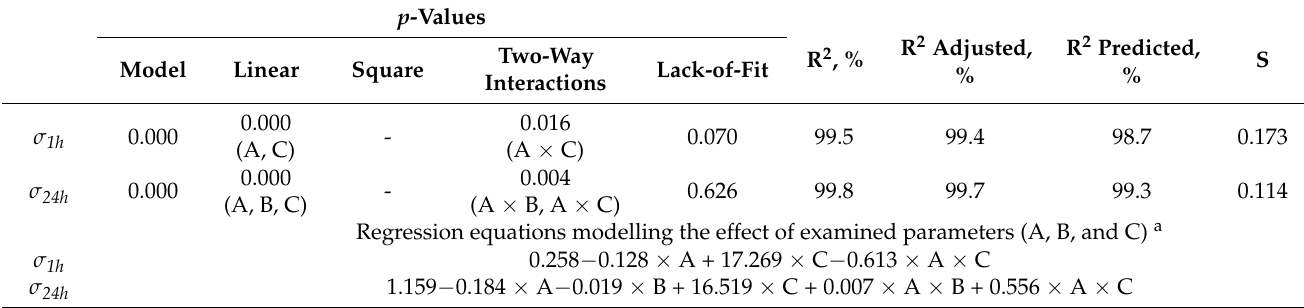
Means of σ 1h and σ 24h , assessed for the Box-Behnken response surface design were fitted next with full quadratic functions, including linear (A, B, C), square (A 2 , B 2 , C 2 ), and combined (A × B, A × C, B × C) terms. A backward-elimination-of-terms algo- rithm at α = 0.05 was used to select only these terms that were statistically significant and contributed to the changes in σ 1h and σ 24h of PALs produced in the FLC-dc-APGD- based reaction-discharge system. The model hierarchy was kept in this case, leaving all lower-order terms that comprised higher-order terms. Statistically significant terms in the regression models of σ 1h and σ 24h along with the respective p -values confirming this significance and the lack-of-fit test are gathered in Table 2. Detailed analyses of variance (ANOVA) summaries with the statistics for both response surface regression models are given in Table 3. Values of R 2 , adjusted R 2 , and predicted R 2 are included in Table 2 to point out goodness-of-fit and the forecast performance of both models. Table 2. p -values for response surface regression models as well as linear and square effects of parameters A, B, and C along with their two-way interactions included in these models to describe changes in σ 1h and σ 24h (in mS cm − 1 ) of PALs produced by using the continuous-flow FLC-dc-APGD reaction-discharge system. Statistically significant terms included in the developed regression models are given in